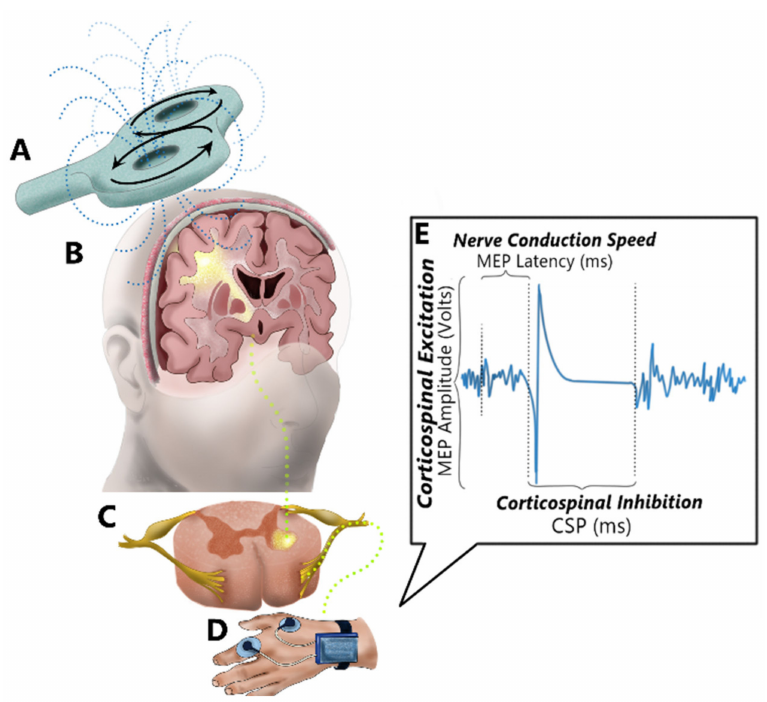
Figure 1. Basic Neurophysiological Principles of Transcranial Magnetic Stimulation (TMS). Electrical current produced by the stimulator travels via an insulated wire and reaches the stimulator coil (e.g., figure of eight coil) ( A ). The direction of flow of the electrical current within the coil (black arrows) is able to generate a perpendicular magnetic field (blue dotted lines), that ( B ) passes through the scalp painlessly and activates corticospinal neurons in the primary motor area by electromagnetic induction. ( C ) TMS elicits descending corticospinal volleys from the brain to the spinal cord by directly activating pyramidal tract neurons or indirectly via interneurons that synapse on the pyramidal tract (D- and I-waves, respectively); these signals elicit a motor evoked potential (MEP) in the contralateral muscle under investigation (e.g., first dorsal interosseous muscle). ( D ) TMS-induced MEPs are recorded via electromyography (EMG), with recording electrodes placed over the belly of the target muscle. ( E ) Offline analysis of corticospinal excitability (e.g., MEP peak-to-peak amplitude) and intracortical inhibition (e.g., cortical silent period (CSP) duration; MEP onset to return of EMG background activity), and corticomotoneuronal conduction speed (e.g., MEP latency; time from TMS stimulus to MEP onset) from a TMS-elicited MEP recorded by EMG of the first dorsal interosseous muscle with a participant performing a tonic voluntary contraction (e.g., pinch grip). Original figure © Arthur